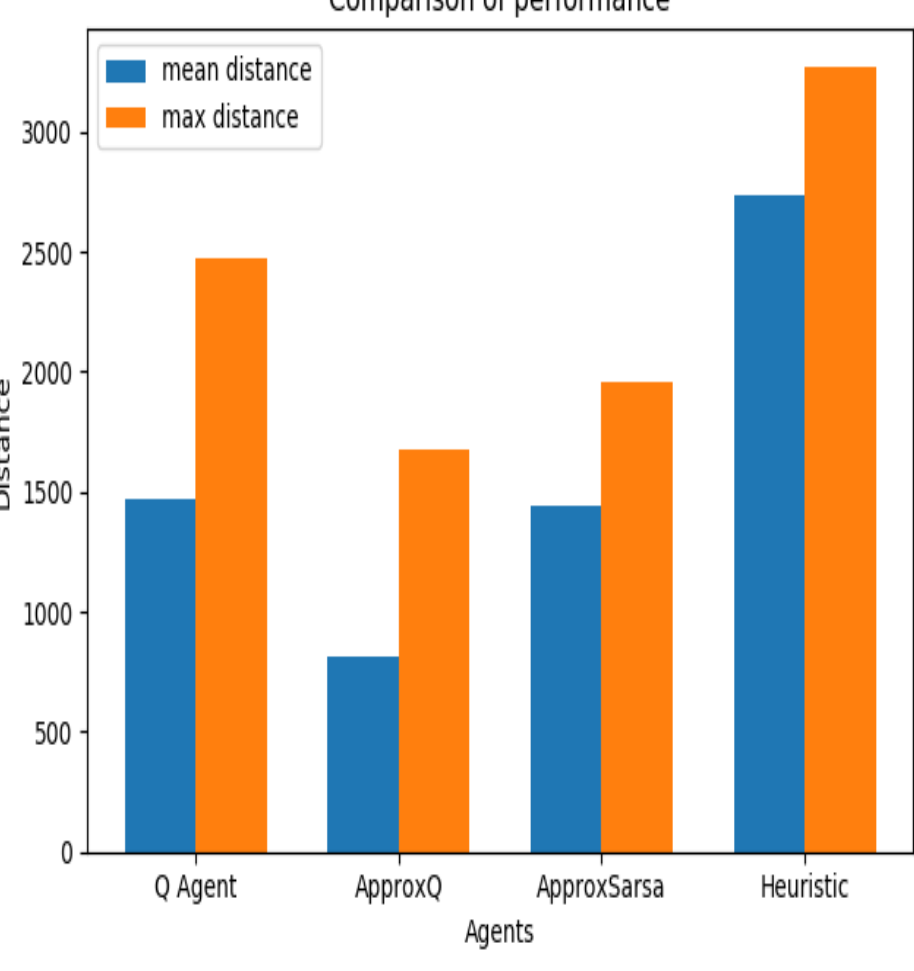
Figure 10. Performance comparison plot—depicts mean distance (blue colour) and maximum dis- tance (orange colour) after 100